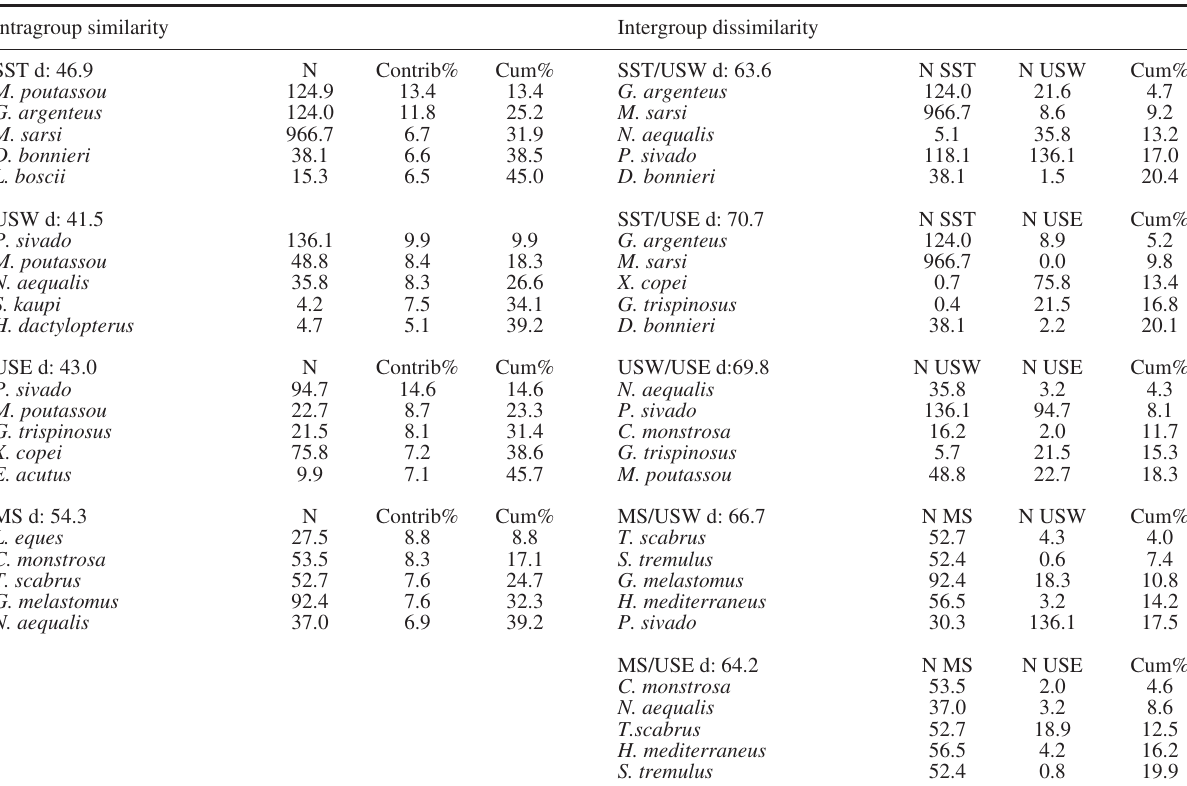
Table 3. – Results of the SIMPER analysis applied to the cluster groups on log-transformed fish and invertebrate. The table shows the contribution (Contrib.%) and cumulative (Cum.%) percentage of the species that most contribute to the intragroup Bray-Curtis similarity and intergroup dissimilarities, together with the N of each